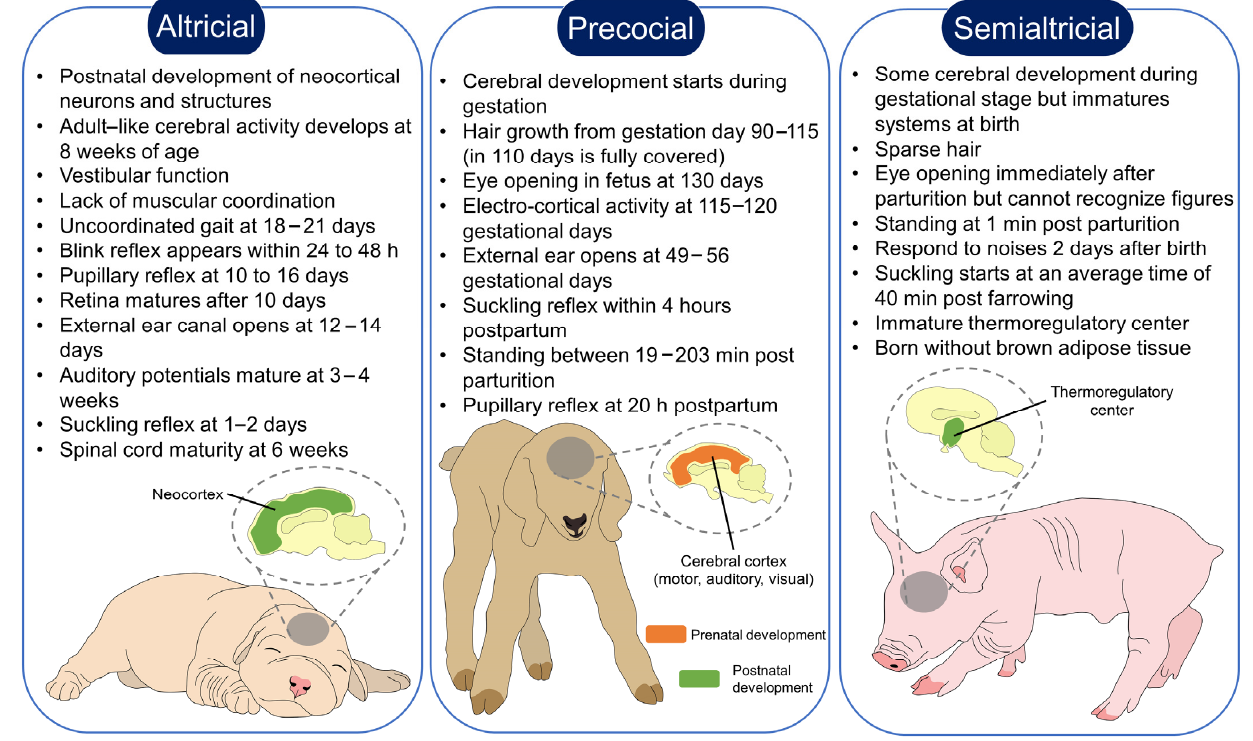
Figure 1. Neurodevelopmental differences between altricial, precocial, and semi ‐ altricial species. According to the type of species, newborns from altricial, precocial, and semi ‐ altricial females establish a different degree of bonding. In the case of precocial species, whose cerebral development starts during gestation, the time they require for maternal nursing is shorter since they can stand and move freely almost immediately after birth. In contrast, the maturation of sensorial systems in altricial species occurs during the postnatal period, where they are completely dependent on the mother to survive. Semi ‐ altricial species are in between; while some of their senses are functional at birth, the mother nurses them until they are highly independent after several days after parturition.